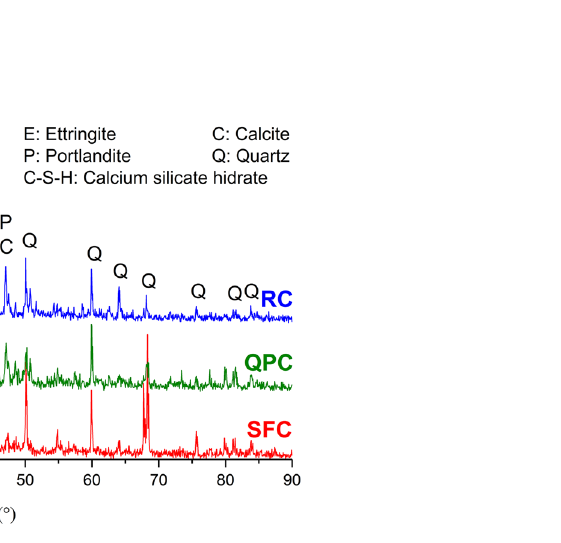
Figure 4. XRD traces of the RC, SFC and